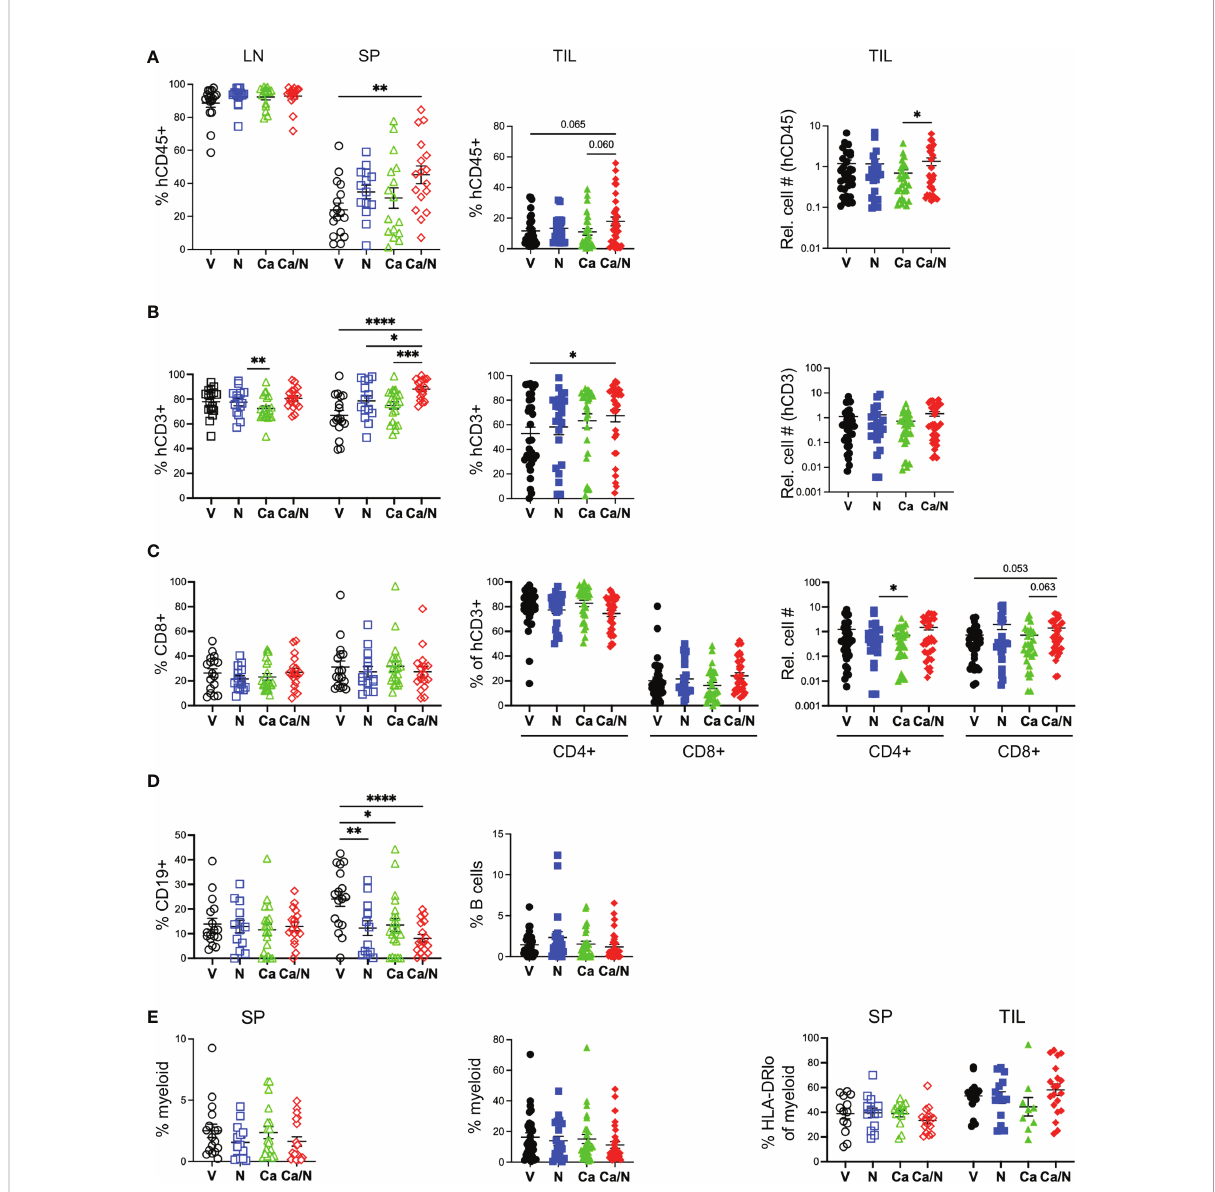
FIGURE 2 Increased human T cells in spleens and TILs of HIS-CRC-BRGS mice treated with combination cabozantinib and nivolumab. The HIS in LNs, spleens and tumors from HIS-CRC-BRGS mice were analyzed by fl ow cytometry for human immune subset frequencies (%) and cell numbers per g of tumor: (A) overall human (hCD45+) as a percentage of total immune cells (human + mouse CD45+), (B) T cells (CD3+), (C) CD4 and CD8+ T cells, (D) CD19+ B cells and (E) human myeloid cells as determined by markers CD11b, CD11c, CD14 or CD33. Right panel is frequency of myeloid cells with low HLA-DR class II expression. V=untreated, N=nivolumab alone, Ca=cabozantinib alone and Ca/N=combination cabozantinib and nivolumab. P-values indicate ANOVA multiple comparisons with Welch ’ s correction: *p < 0.05, **p < 0.01, ***p < 0.001, ****p < 0.0001 or as indicated by